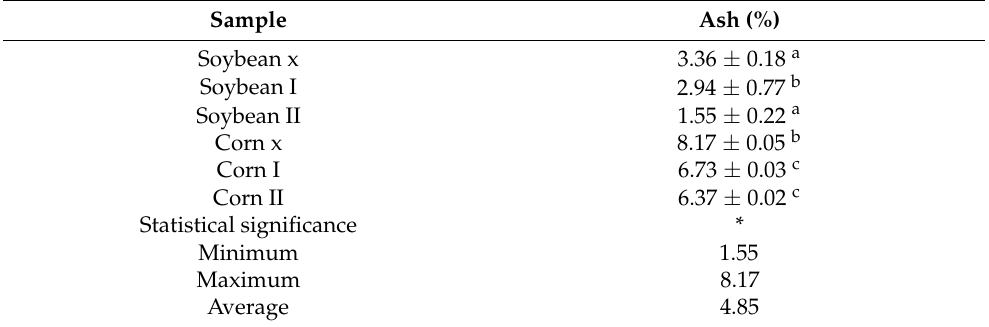
Table 1. Initial ash content in unsieved corn and soybean (x), corn (I, II) and soybean (I, II) samples.